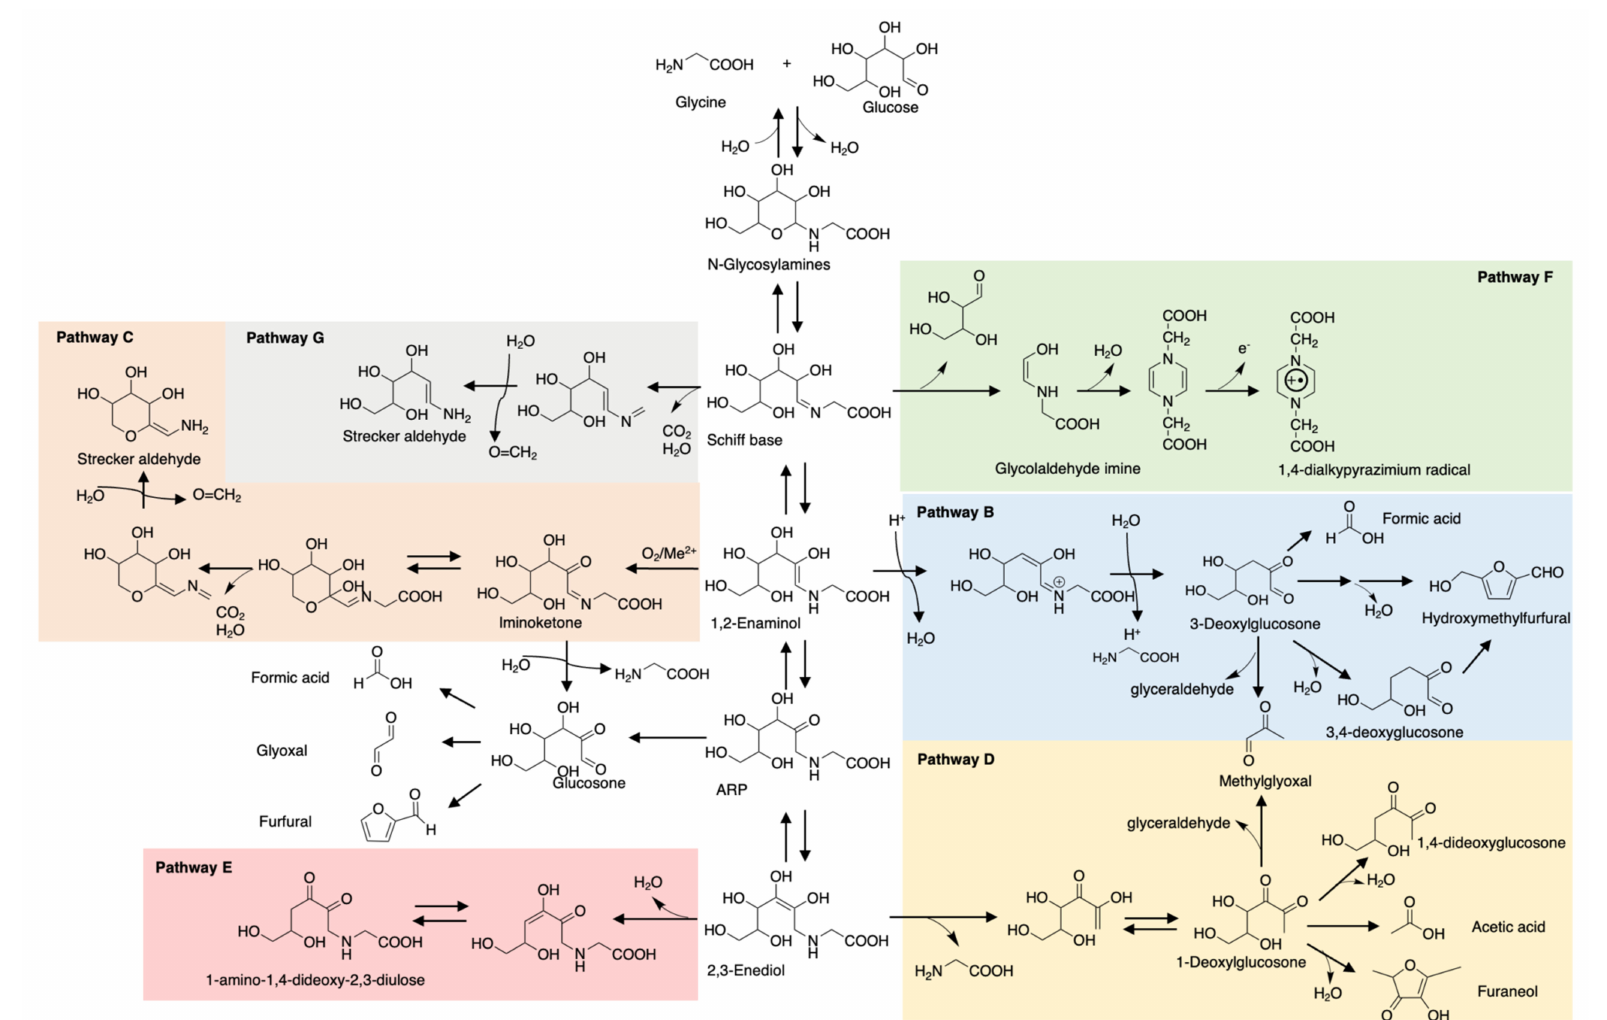
Figure 1. Degradation pathways of glycine-glucose-ARP. B. 1,2-Enolization pathway; C. Oxidative degradation pathway; D. 2,3-Enolization pathway; E. Elimination of C 4 -OH group of 2,3-enediol pathway; F. Cleavage of sugar moiety pathway; G. Decarboxylation